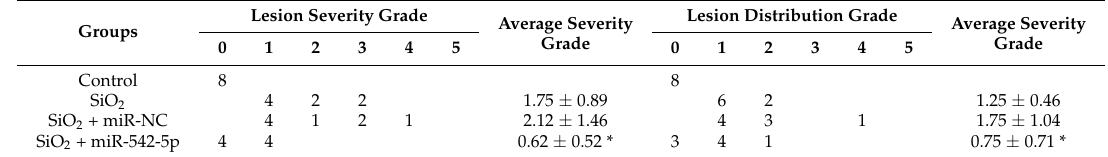
Table 1. Preventive effect of miR-542-5p agomir administration on lung histopathology. Groups